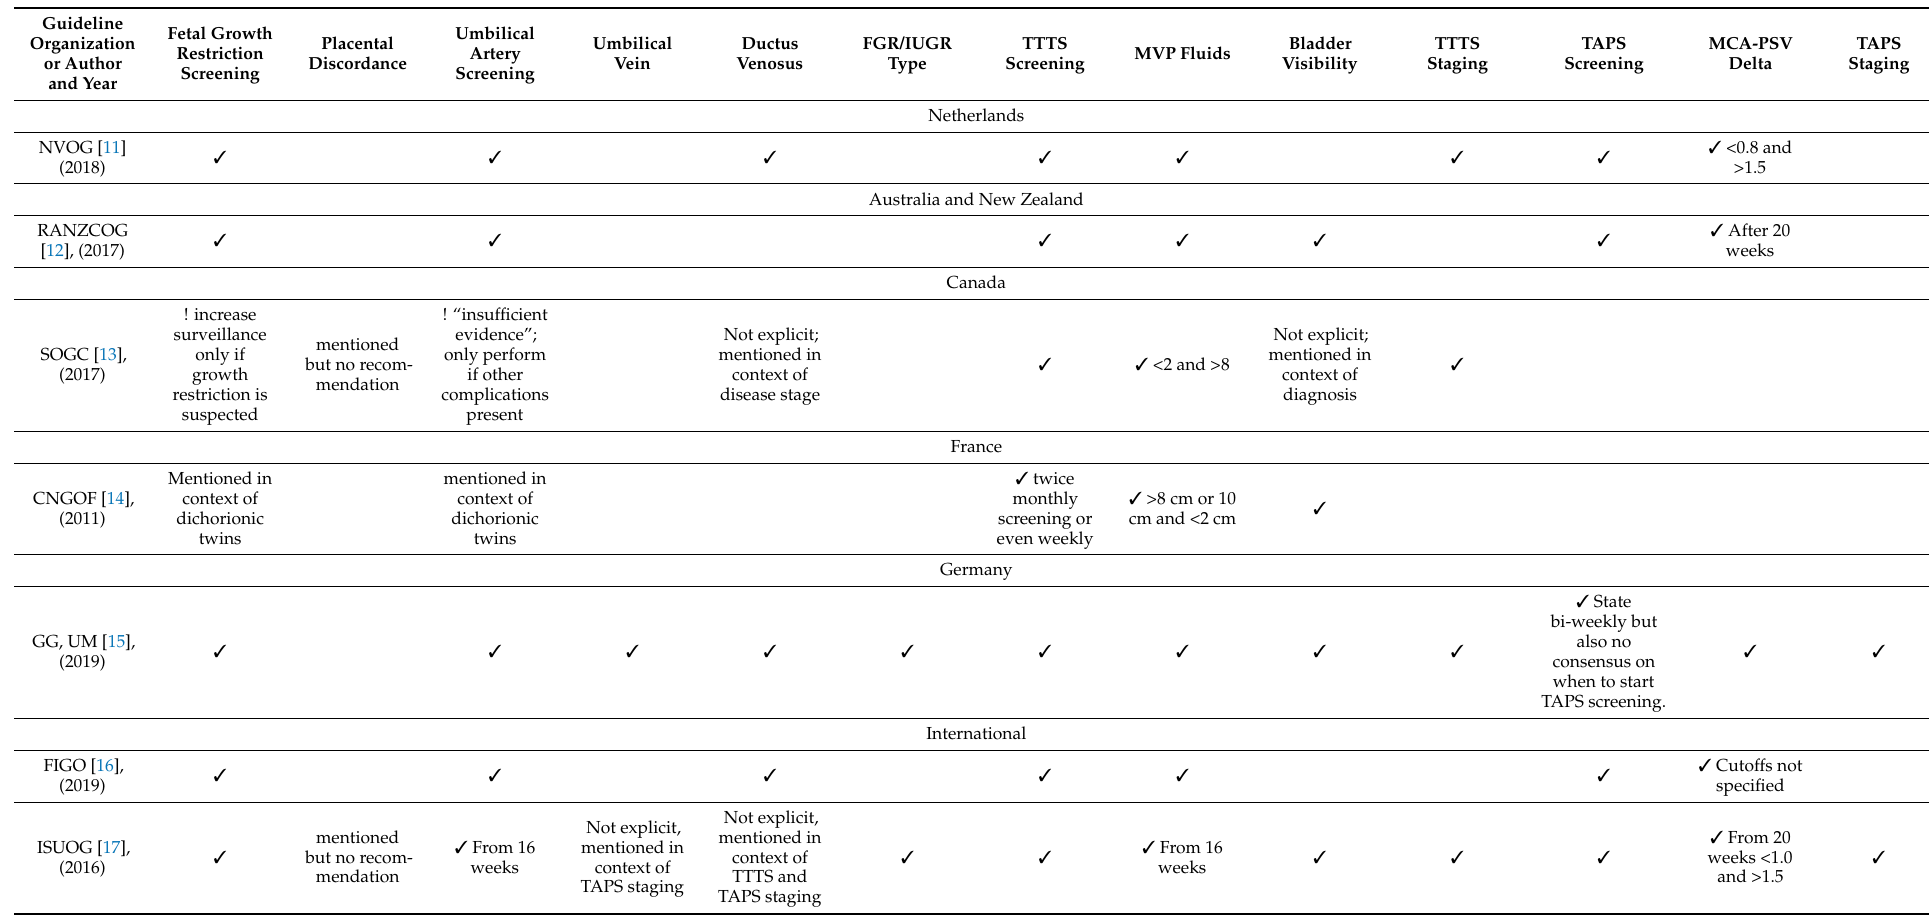
Table 3. Clinical Practice Guidelines for Complication-Specific Screening during Monochorionic